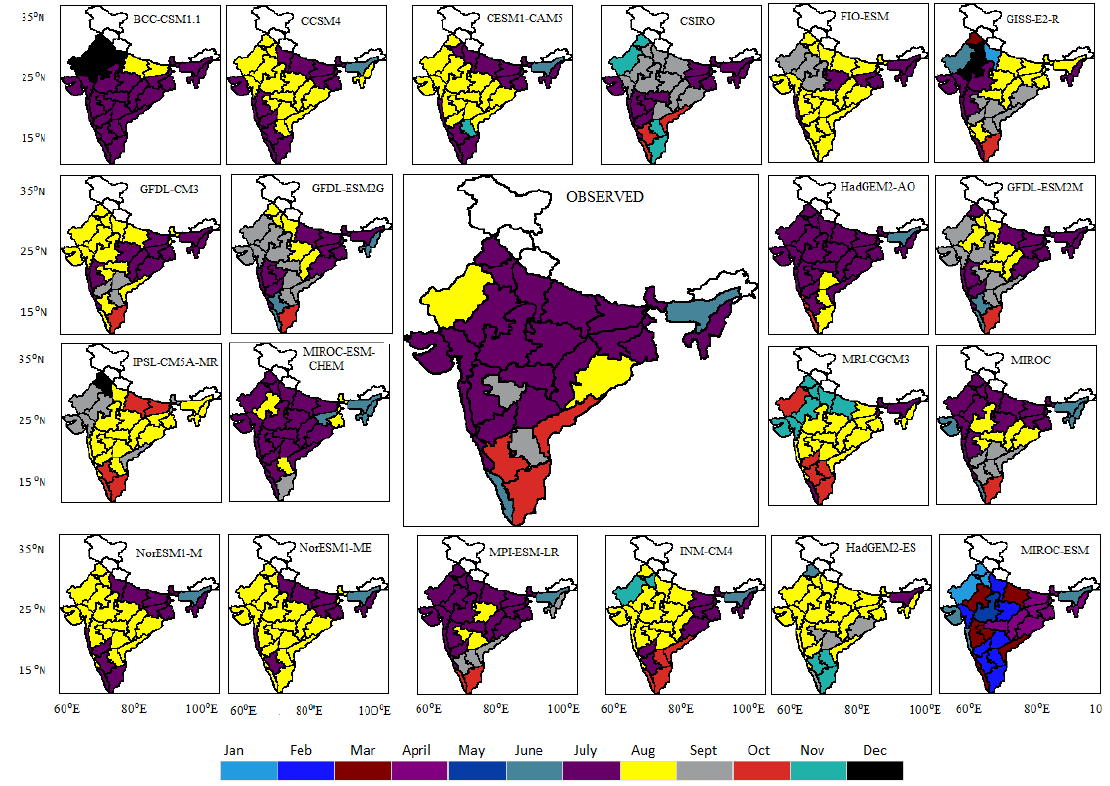
Figure 4. Historical MRPM Indian meteorological sub-divisions of the 20 models.